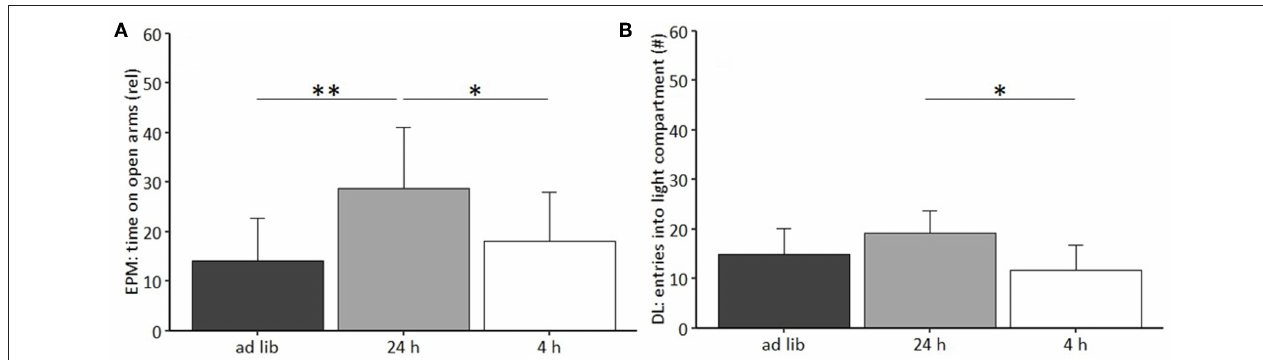
FIGURE 6 | Anxiety-like and exploratory behavior. (A) Elevated Plus Maze (EPM): Relative time on open arms; (B) Dark Light (DL): Number of entries to light compartment. Ad lib , Ad libitum group; 24h, 24h schedule group; 4h, 4h removal group. Data are presented as means ± SD. Statistics: ANOVA, post hoc : Bonferroni-Holm corrected; sample size: n = 12 per group; * p < 0.05, ** p < 0.01.